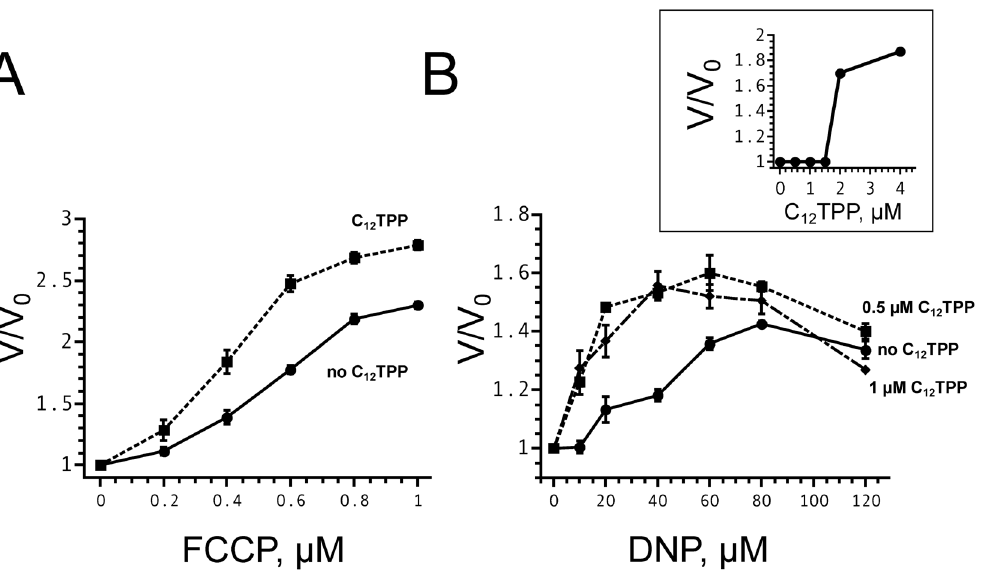
Figure 9. C 12 TPP enlarges the FCCP- and DNP-induced increase in respiration rates of intact yeast cells. The ordinate represents the ratio of the oxygen consumption rates after (V) and before (V 0 ) the addition of an uncoupler. (A) FCCP-mediated stimulation of yeast respiration in the absence (solid line) and in the presence (dotted line) of 1 m M C 12 TPP. (B) DNP stimulation of yeast respiration in the absence (solid line) and in the presence of 0.5 m M (dotted line) or 1 m M (dot and dash line) C 12 TPP. In the absence of the anionic uncoupler, C 12 TPP did not increase the rate of oxygen consumption at concentrations below 2 m M (insert). Shown are Mean 6 S.E. of 4 experiments.